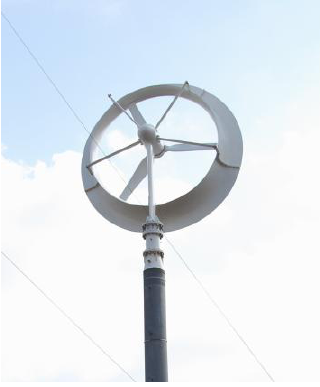
is the power coefficient. w